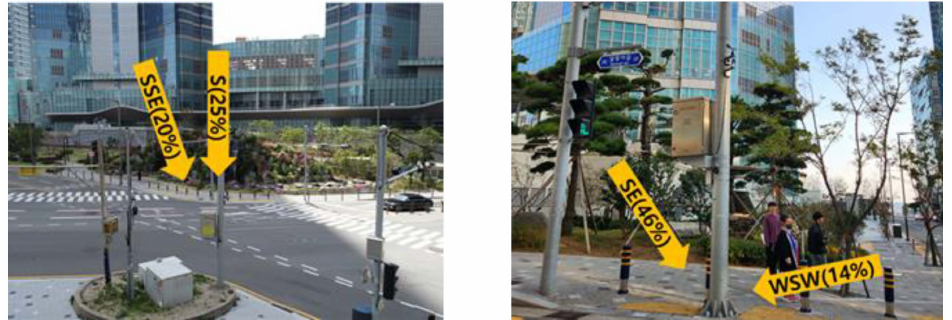
Figure 11. Main wind direction for L-3 ( left ) and L-4 ( right